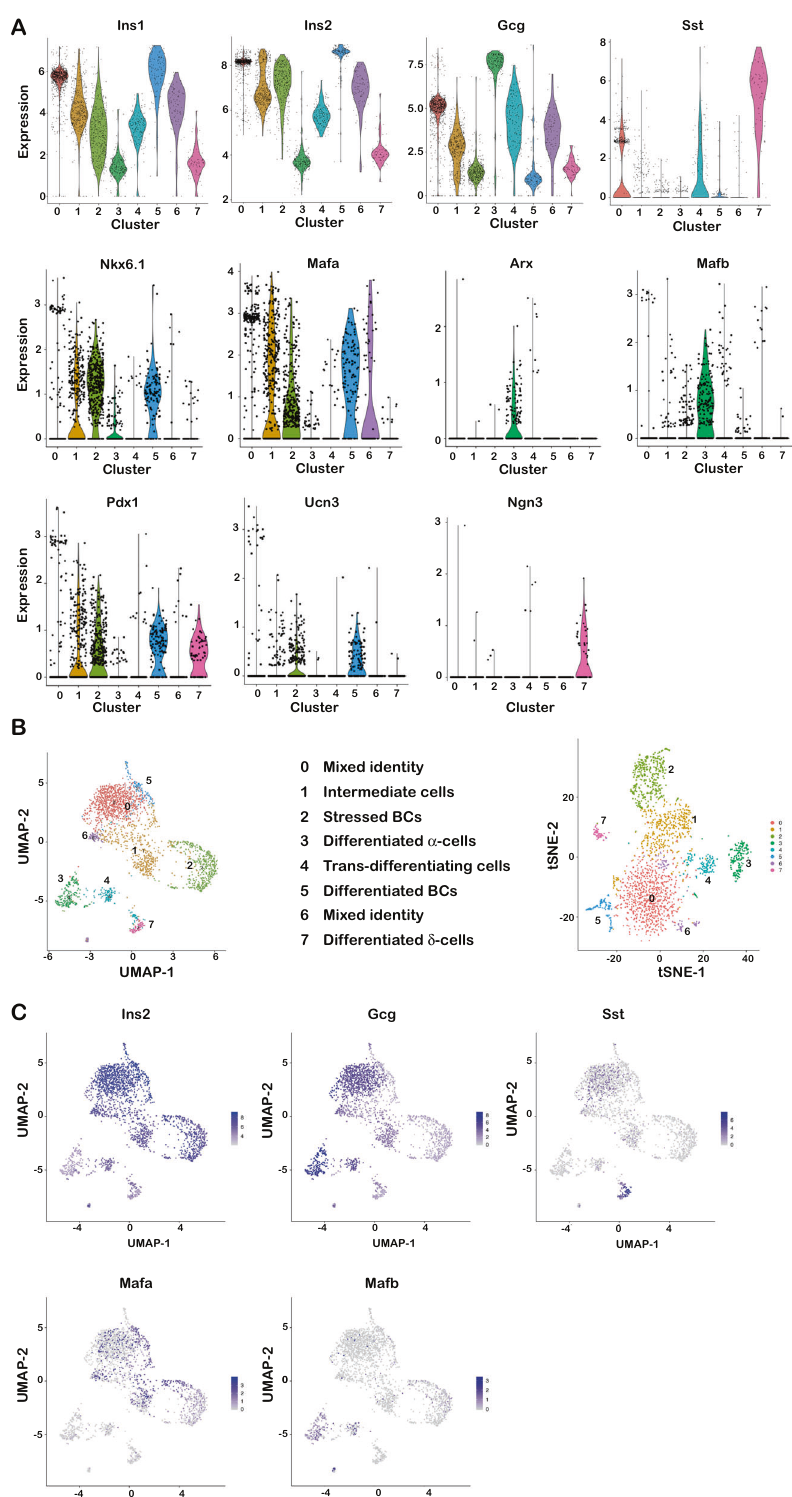
Fig. 5 Sc-RNA-seq of week 1 mutant islets. A Violin plots of expression of the indicated genes in each cluster. B UMAP (left) and tSNE (right) representations of the cell populations. C UMAPs illustrating the expression of the genes indicated in each panel. show activity of the Mafg, Yy1, Atf5, Atf3, and Bhlhe41 regulons activity of both Mafa and Mlxipl. Mafb was active in the alpha cell together with those of Jun and Fosb (AP1). Similarly, the stressed populations, but contrary to week 1 no overlap of Mafa and Mafb Taf4 − / − alpha cells also showed elevated AP1 and Atf3 activity. activities was seen. Several Taf4 + / + beta cell populations characterized by stress response as described above did however Taf4 − / − beta cells also showed elevated activity of chromatin Cell Death and Disease (2021)